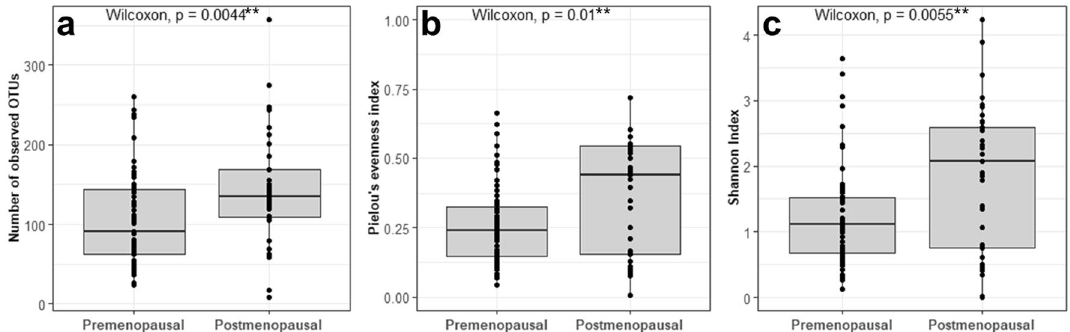
Figure 1. Alpha-diversity of the urinary microbiota in pre- and postmenopausal women depicted using ( a ) Number of observed OTUs, ( b ) Pielou’s evenness index, and ( c ) Shannon diversity index.